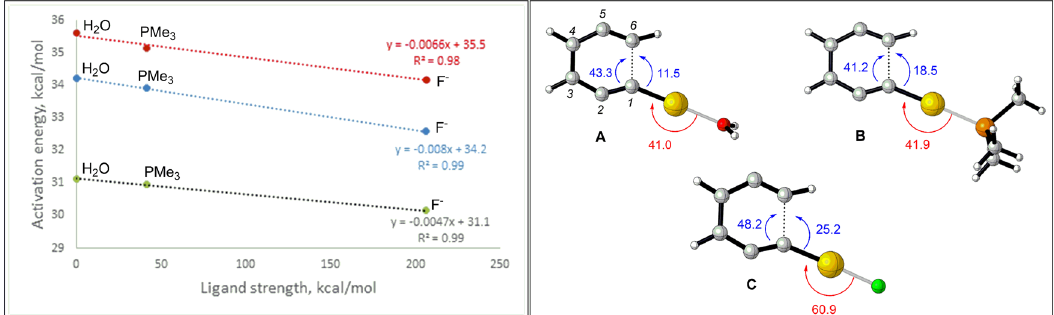
Fig. 5 Plot on the left shows the dependence of activation energy on the strength of the ligand. Red, blue, and gray dotted lines in the plot correspond to the activation energies calculated at the B3LYP/6-311 + G**/def2-TZVP, B3LYP/LANL2DZ, and PBE0/6-311 + G**/def2-TZVP levels respectively. Structures A , B and C on the right correspond to the transition state geometries of substrates consisting of H 2 O, PMe 3 , and F − attached to the Au(I)-acetylide, respectively. The values in red and blue correspond to interaction energies expressed in